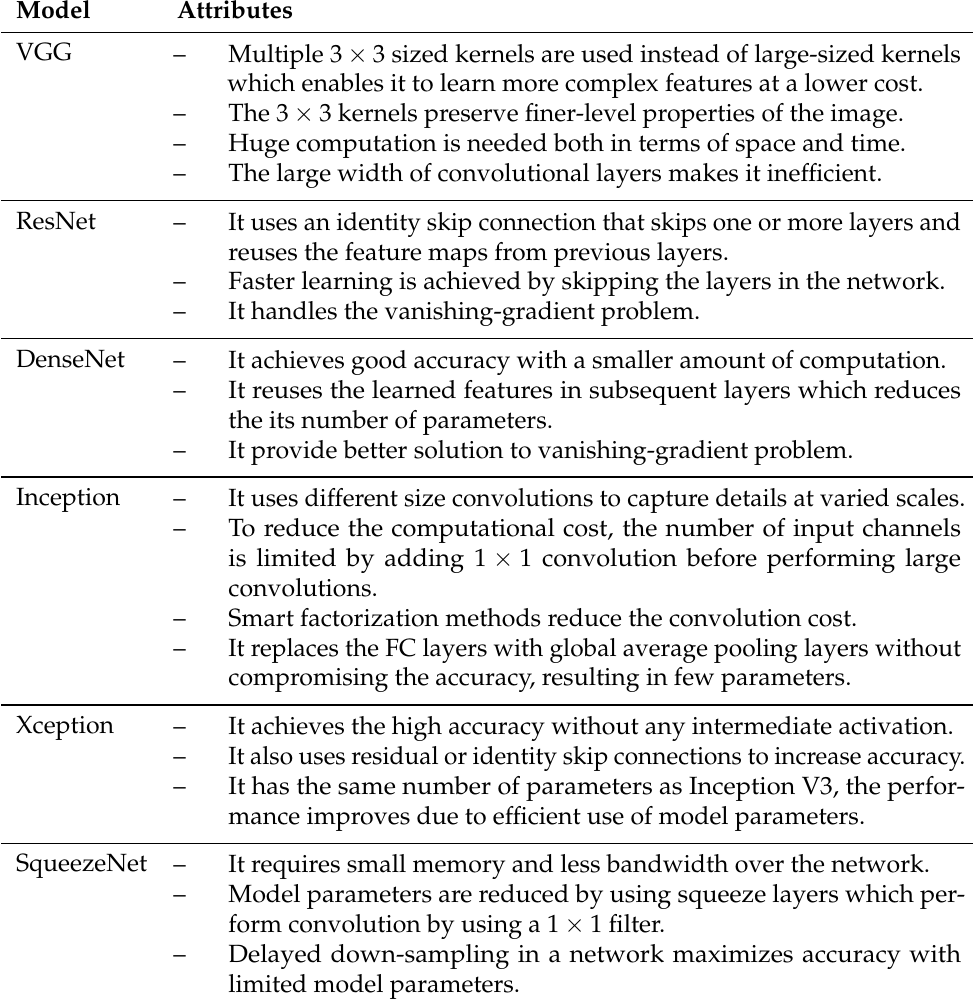
Table 1. Summary of attributes of the compared deep learning